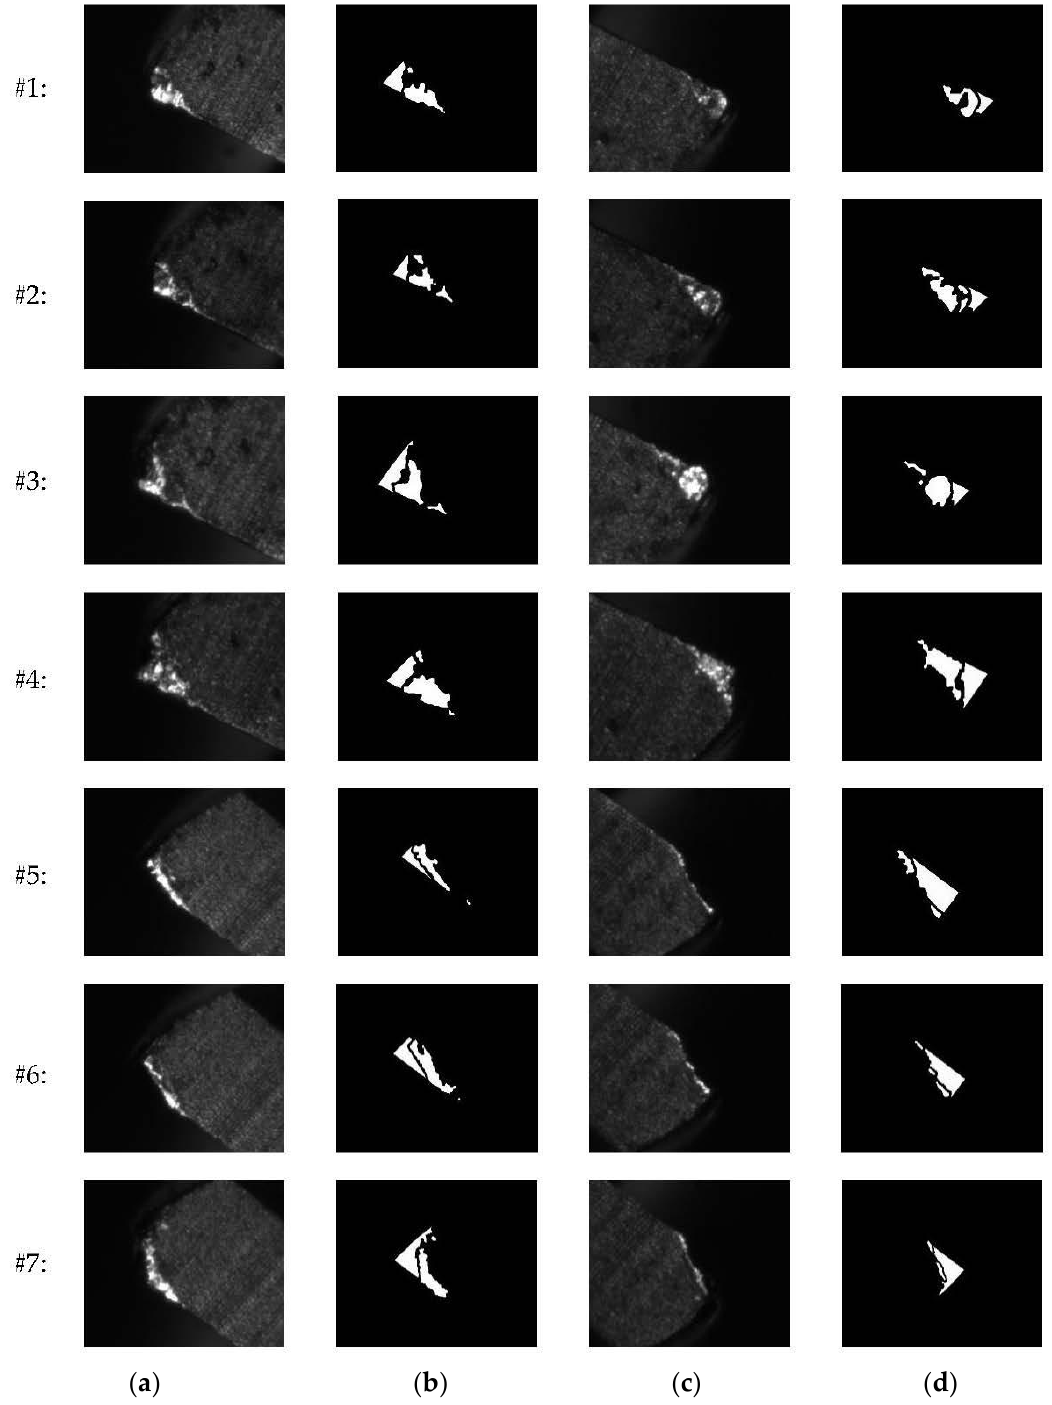
Figure 13. The abrasion and breakage extracted by our method. ( a ) Left tool; ( b ) Abrasion and breakage in left tool; ( c ) Right tool; ( d ) Abrasion and breakage in right tool.